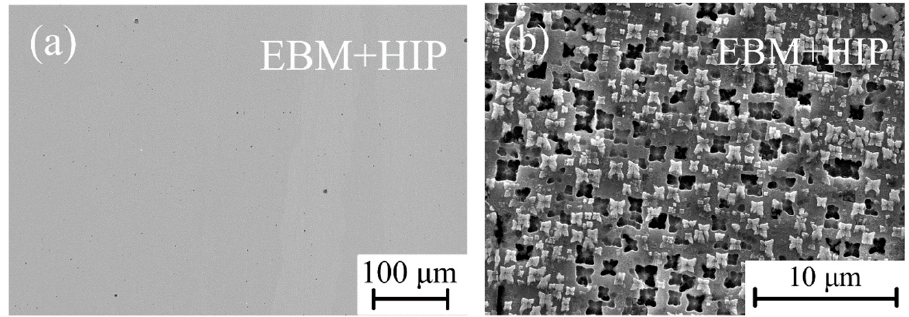
Figure 8. SEM micrographs of EBM+HIP PREP sample. Healed cracks after HIP ( a ) and the butterfly-like γ′ precipitates ( b ).